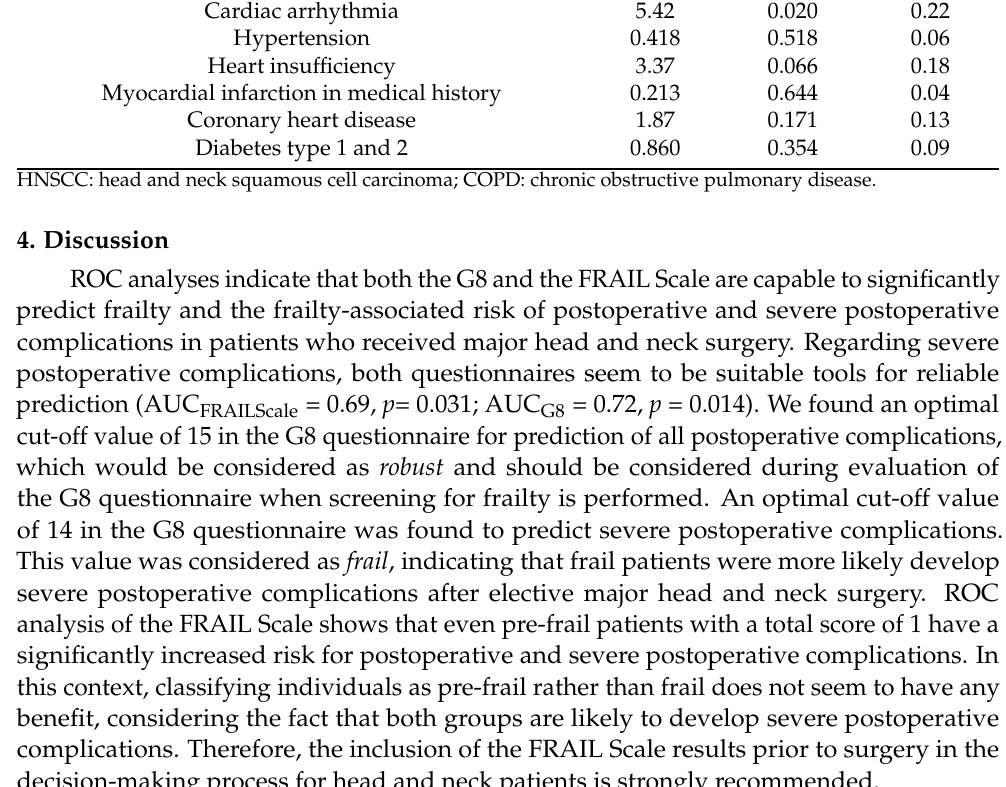
Existing medical conditions (HNSCC vs. other)